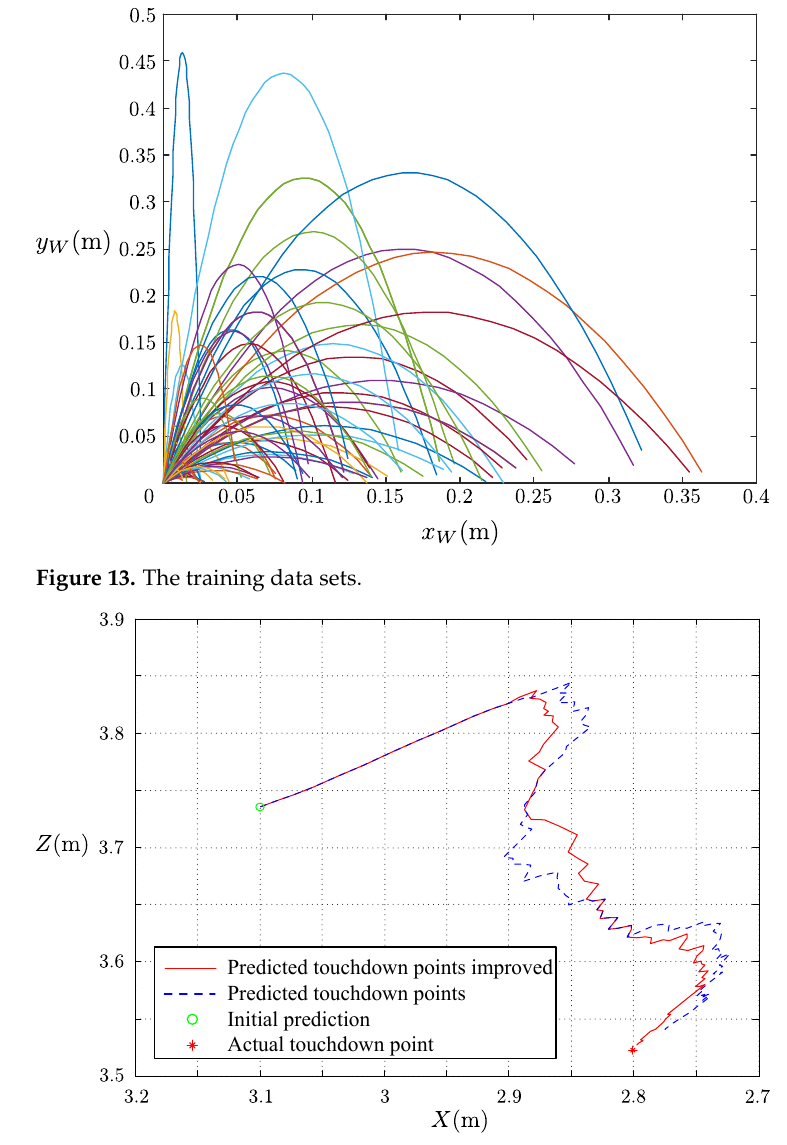
Figure 14. Prediction of the touchdown points improved by deep